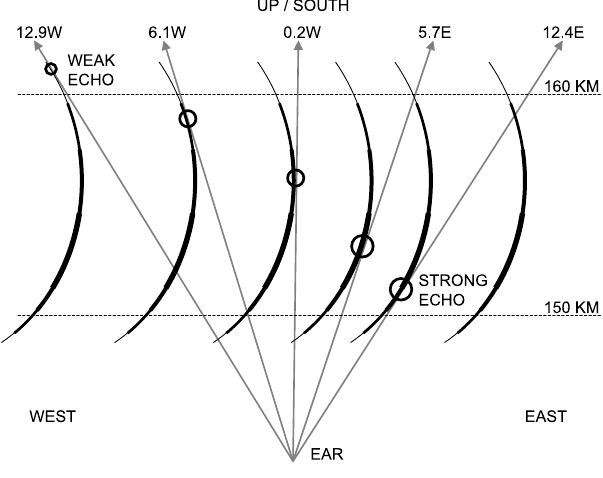
Fig. 8. A schematic model of 150-km echoes in the low-latitude region. Arcs indicate echoing regions which return backscatter echoes when radar beams are tangential. The thickness of the arcs represents the intensity of backscatter echoes produced on the arcs.